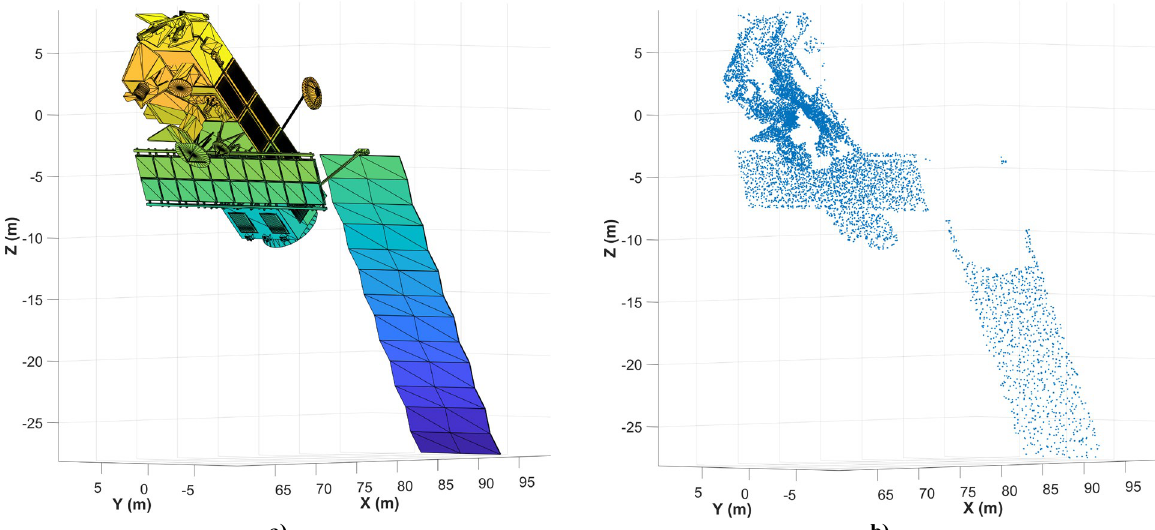
Figure 12. Point cloud simulation. a) 3D model of the satellite. b) Point cloud generated for the given 3D